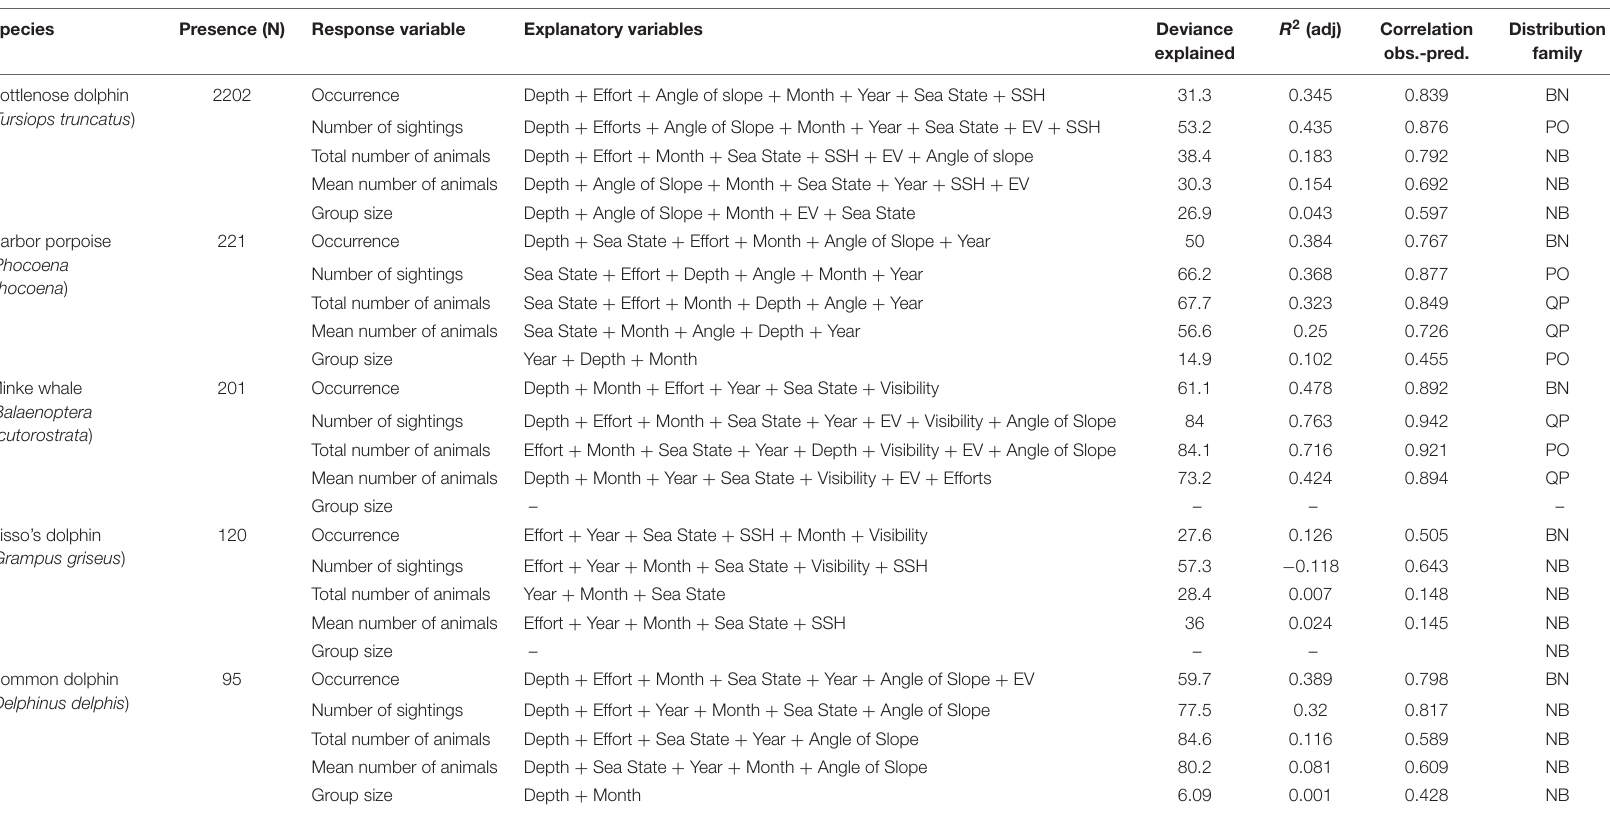
TABLE 7 | Models results for each species: number of presences, response variables, explanatory variables selected by the models (in descending order of importance according to deviance explained), total deviance explained, R 2 adjusted, correlation between the observed and the predicted values and distribution family used. Species Presence